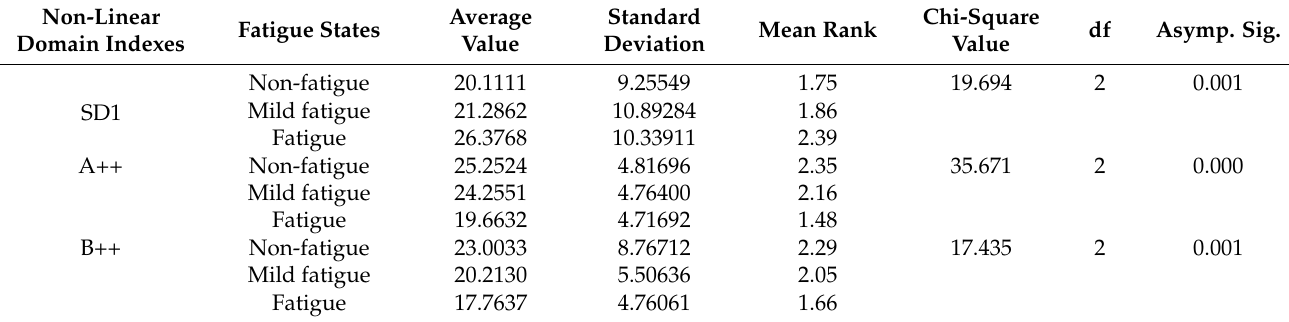
Table 9. Feature selection results of non-linear domain indexes.